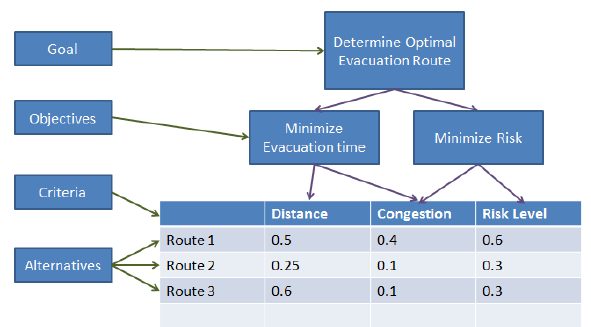
Figure 3. MCDM decision